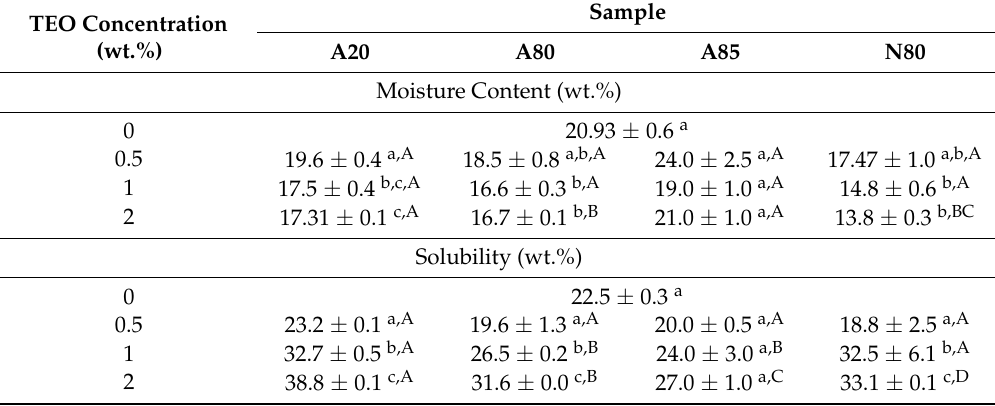
Table 8. Moisture content and solubility of chitosan